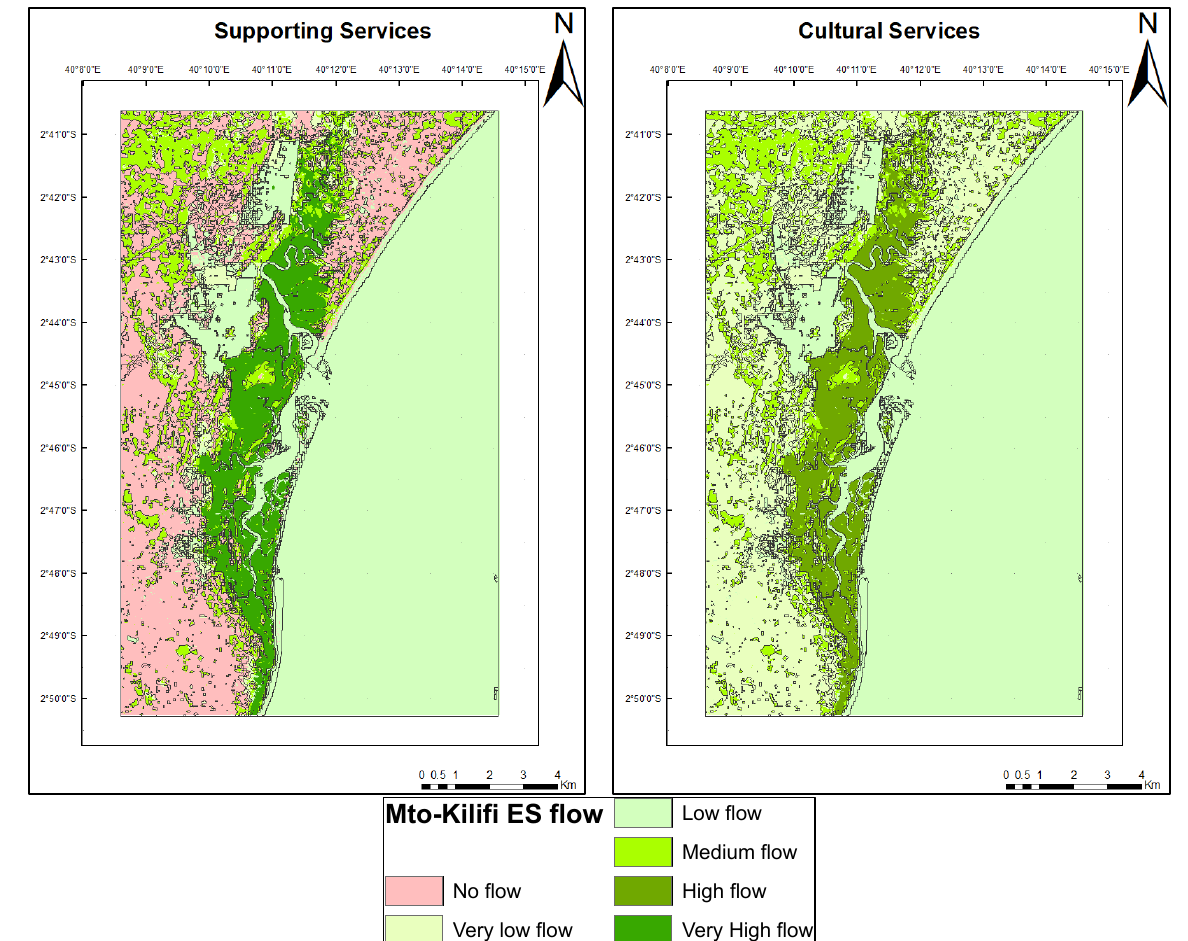
Figure 5. The spatial distribution of ES flow for provisioning, regulating, supporting, and cultural services provided in Mto-Kili fi (Ungwana bay, Kenya).